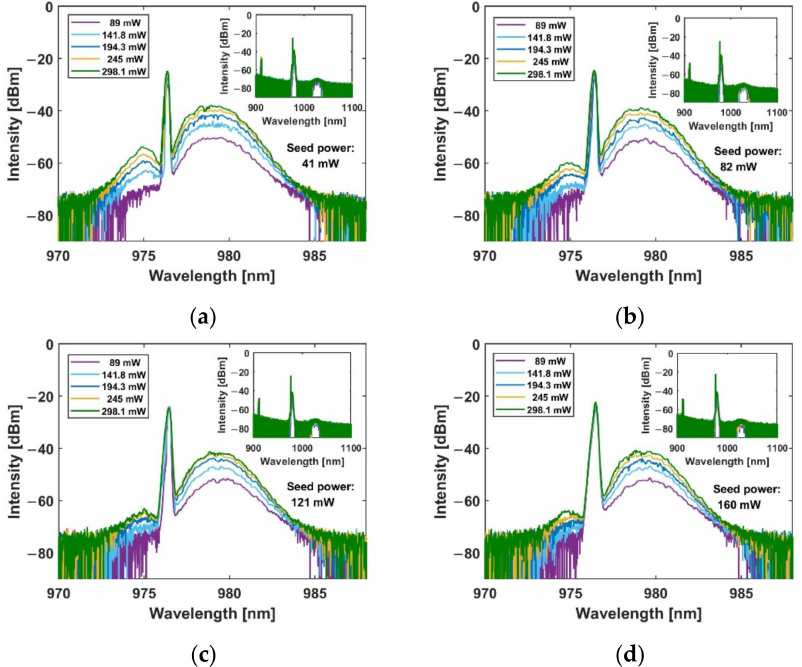
Figure 3. Four figures of output spectra via pump power corresponding to four seed power values corresponding to 41 mW, 82 mW, 121 mW, 160 mW ( a – d